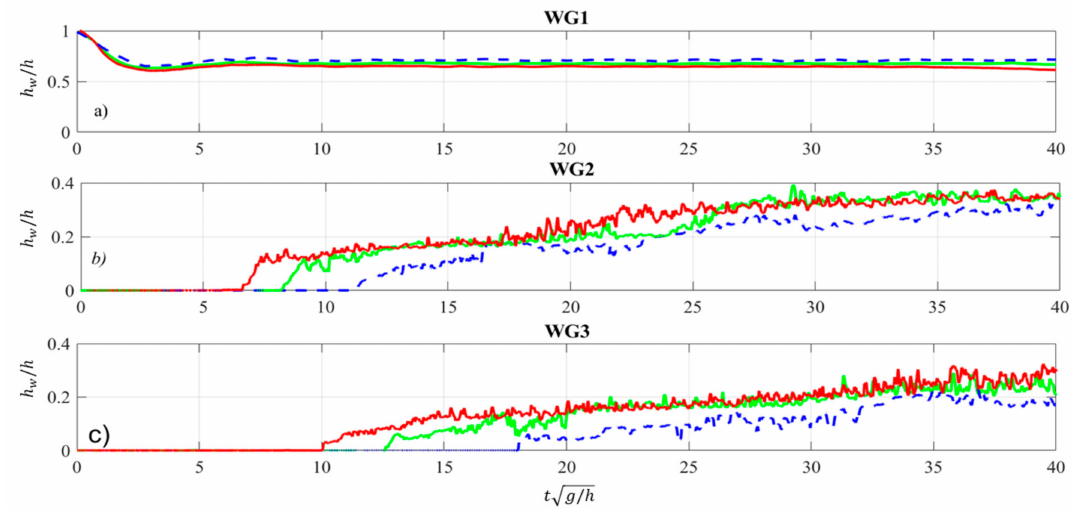
Figure 5. Dry bed surge time-history of the water surface profile. h = 50, 40, 30 cm measured at location of the ( a ) reservoir wave gauge (WG1), ( b ) x = 3.5 m (WG2) and ( c ) x = 5.5 m